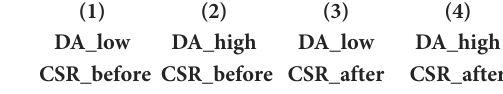
TABLE 7B 2012 labor protection policy change. TABLE 8 Difference–in–differences propensity score matching